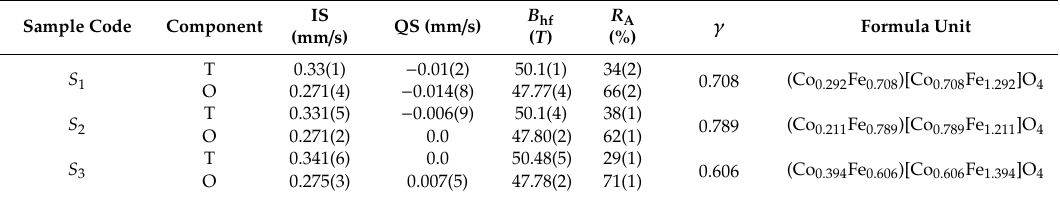
Figure 12. Mössbauer spectra of the powder samples S 1 ( a ), S 2 ( b ) and S 3 ( c ). Table 3. Hyperfine parameters, relative areas, inversion degree and formula units obtained from the Mössbauer spectra. The errors on the last digit are found in brackets.